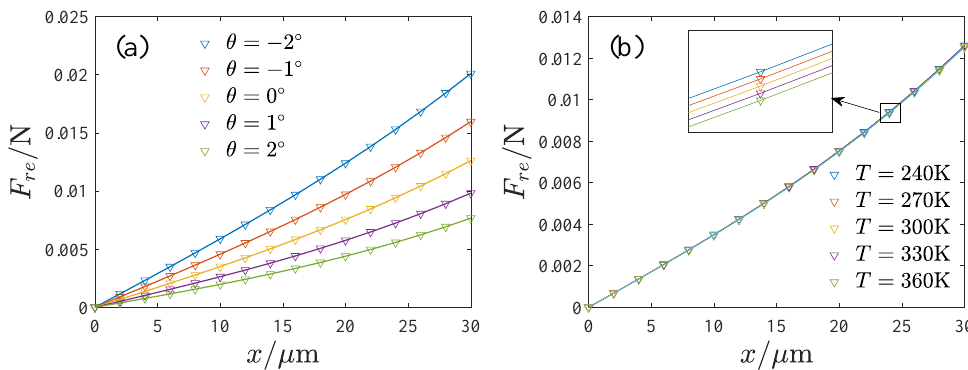
Figure 6. The relation between the displacement and the restoring force, where the symbols denote the FEA results and the lines denote the fitting results. ( a ) The effect of the inclination angle, ( b ) The effect of the temperature.